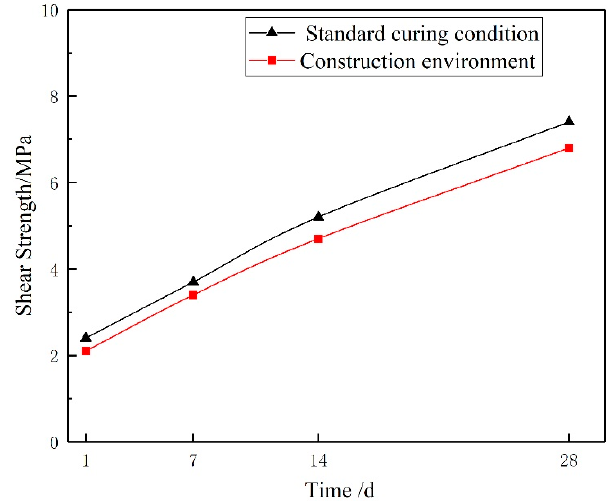
Figure 13. Shear strength of interface between H-70 and concrete.